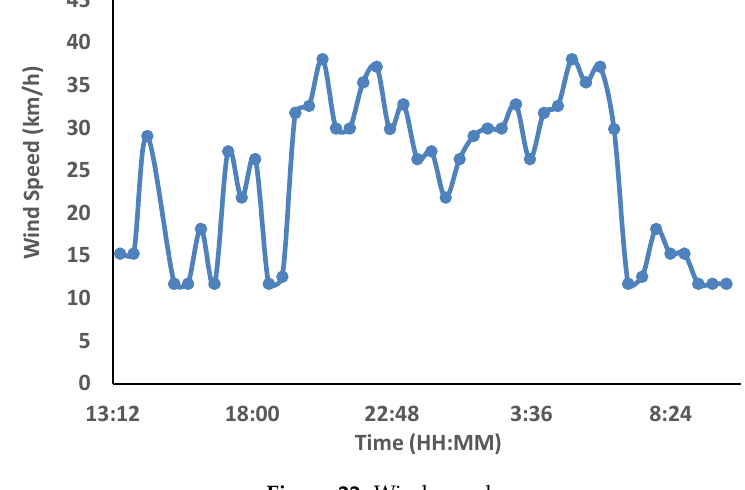
Figure 22. Wind speed. Figure 22. Wind